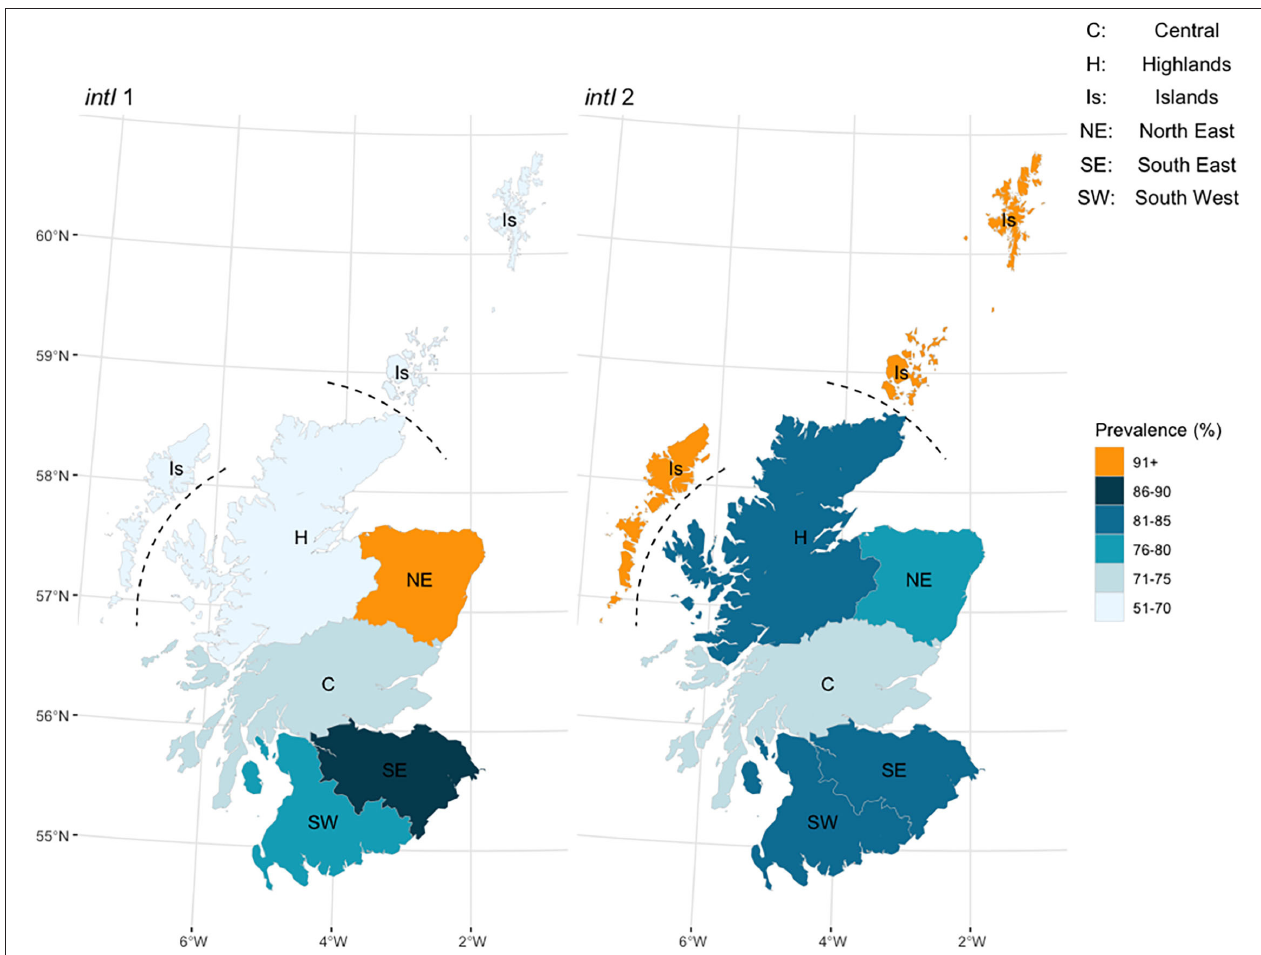
FIGURE 1 | Observed (raw) herd prevalence by Animal Health District region for the integron intI1 and intI2 genes in 108 Scottish cattle herds, by real-time